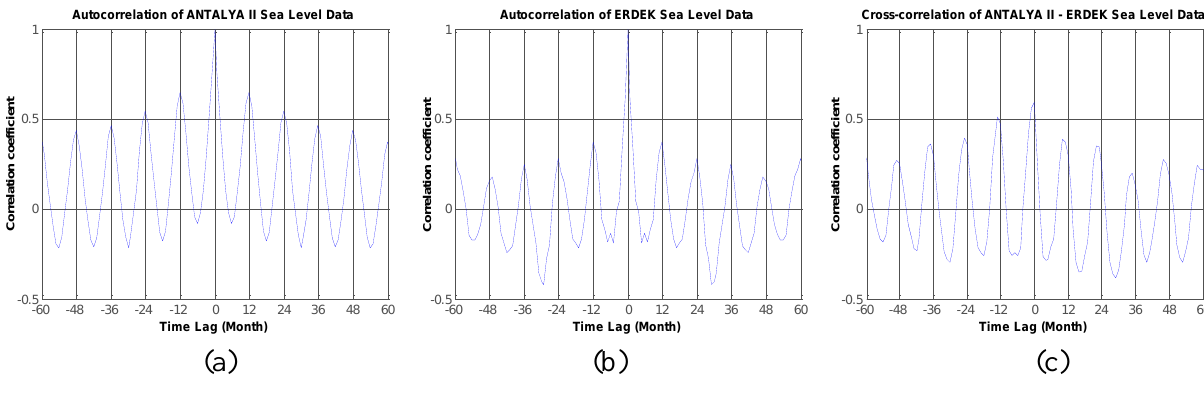
Figure 5. Plots of the autocorrelation functions of the sea-level observations for the (a) Antalya-II and (b) Erdek tide gauges and (c) the cross-correlation function between the time series (sea-level observations) of the Antalya-II and Erdek tide-gauges